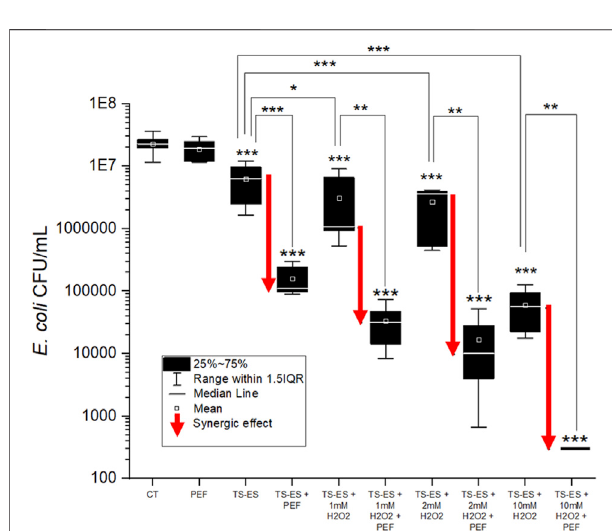
FIGURE 7 | E. coli population (CFU/ml) for the different treatments in PAW induced by TS-ES open air reactor without and with adding different concentrations of H 2 O 2 and without and with PEF treatment. One-way ANOVA test, (*) p -value < 0.05; (**) p -value < 0.01; and (***) p -value < 0.001 with respect to control (CT), or other conditions as indicated by lines. Boxes and whiskers show the median, mean value, interquartile range (IQR), and error bars corresponding to 1.5IQR. Red arrows indicate the bacterial population reduction due to synergy of PEF and PAW.